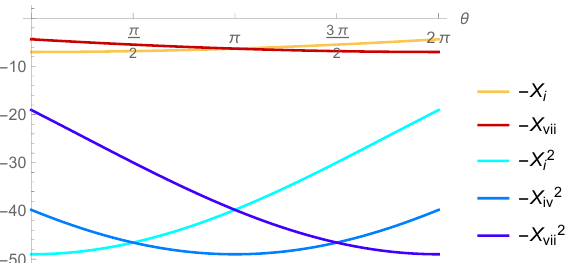
(b) Normalized critical chemical poten- tial ( m = ν = 1 ) above which the su- π perfluid phase is realized as a function of θ .